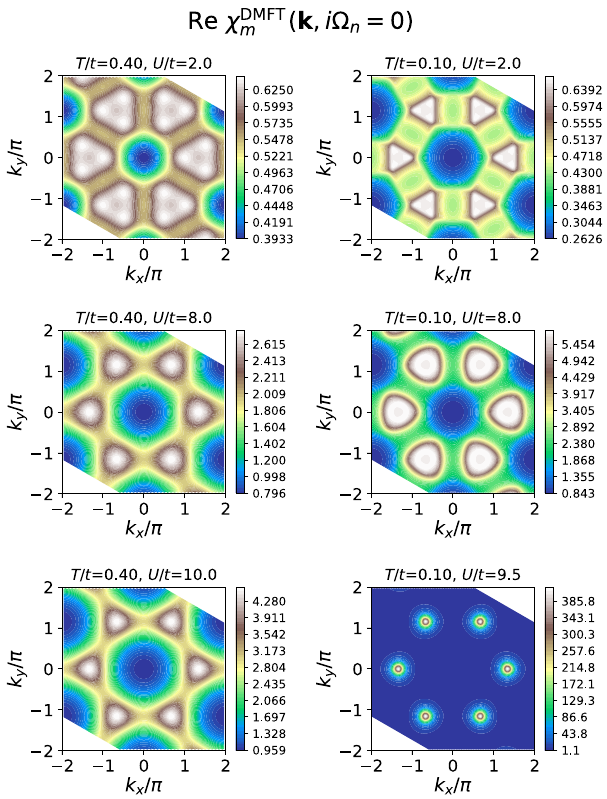
FIG. 14. Momentum dependence of the DMFT magnetic sus- ceptibility at zero frequency for several temperatures and inter- actions. The leading contribution is (centered around) k ¼ K